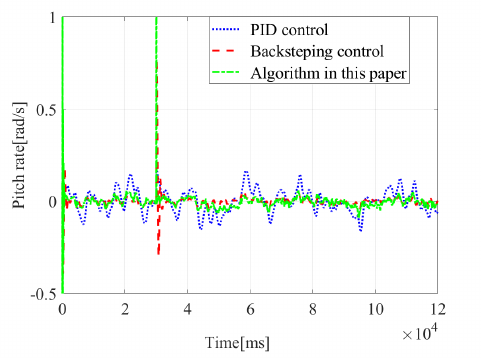
Fig. 3. Pitch angle rate curve in transition phase.